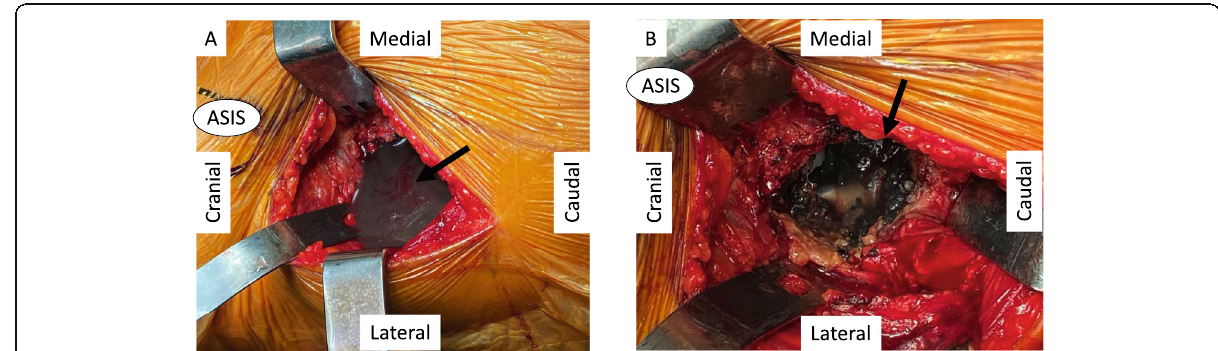
Fig. 3 Intraoperative photographs. A Pigmented metal around the joint (arrow). B Black granulation tissue adhering to the inner surface of the joint capsule